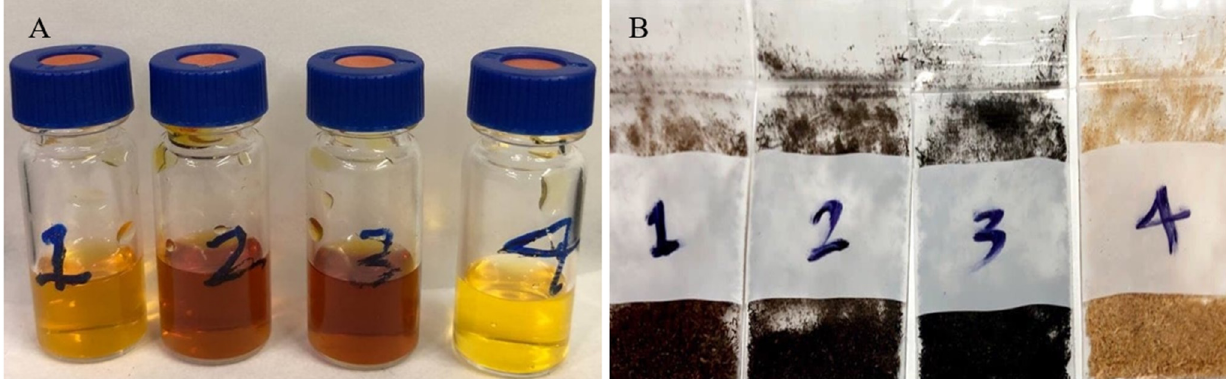
Figure 7. Torrefaction liquids ( A ) from torrefied wood sawdust ( B ). Labels 1-3 are indicators for OT samples torrefied at 230, 260 and 290 °C, respectively and 4 is for optimized treatment at 230 °C.